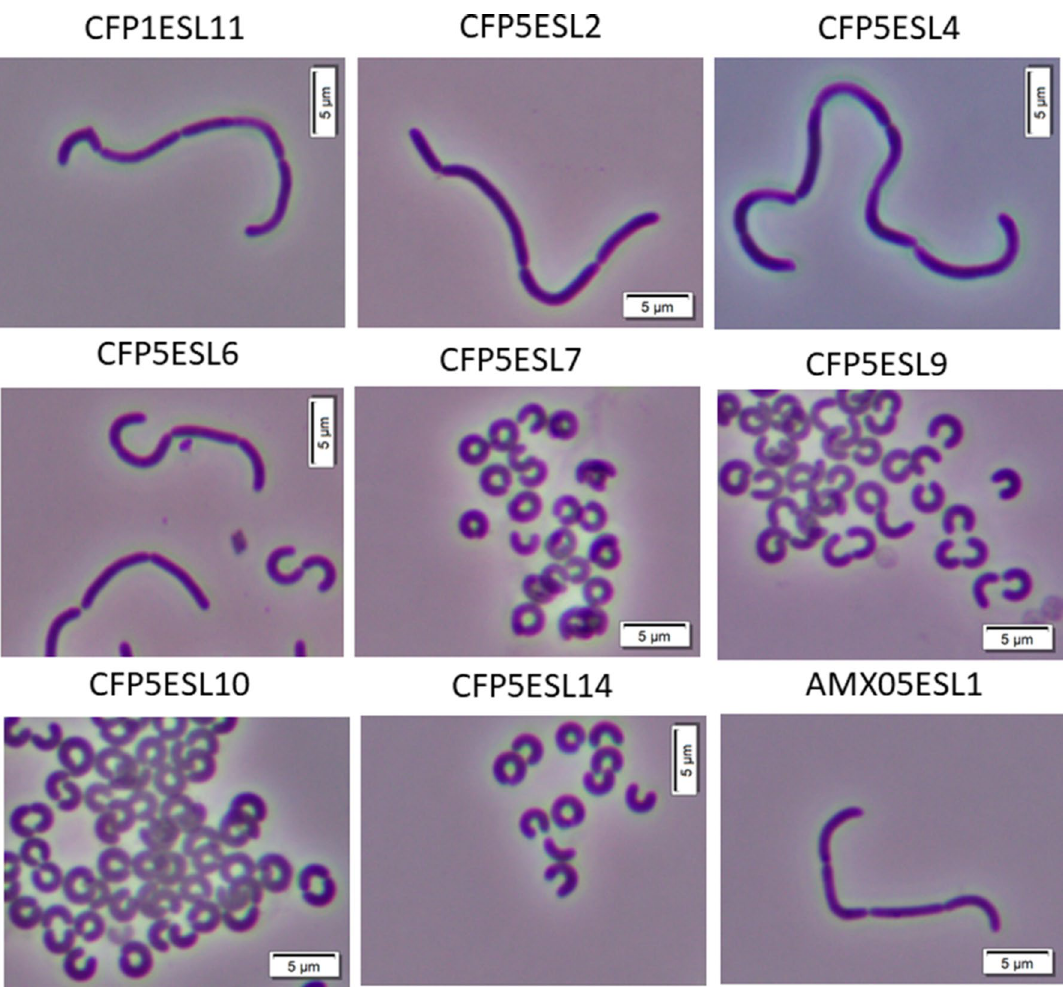
Figure 2. Cell shape of S. linguale cefoperazone- and amoxicillin-resistant clones. Microscopy of the cefoperazone-resistant clones (CFP1ESL11, CFP5ESL2, CFP5ESL4, CFP5ESL6, CFP5ESL7, CFP5ESL9, CFP5ESL10, and CFP5ESL14), and the amoxicillin-resistant clone (AMX05ESL1) cells are shown. Bar, 5 μm. Cells were cultivated in the stationary phase in Spirosoma medium without antibiotics at 26 °C with shaking.